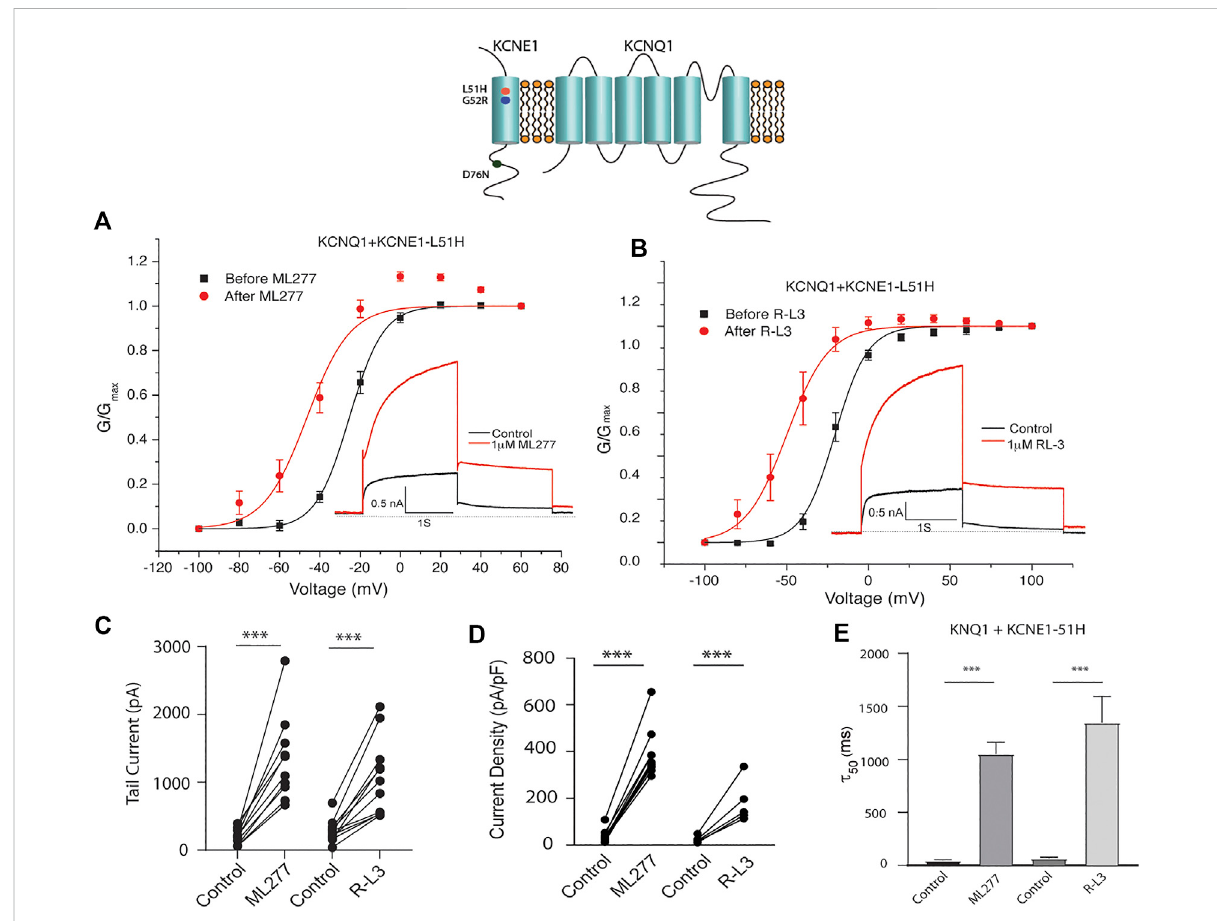
FIGURE 4 Potentiation of KCNQ1-L51H channel activity by ML277 and R-L3. (A) . Normalized conductance/voltage relationship for KCNQ1/KCNE1-L51H channels before (black traces) and after (red traces) application of 1 μ M ML277. The inset shows representative currents recorded at +60 mV. (B) . Normalized conductance/voltage relationship for KCNQ1/KCNE1-L51H channels before (black traces) and after (red traces) application of 1 μ M R-L3. The inset shows representative currents recorded at +60 mV. (C) . Tail current amplitudes measured at − 40 mV in control and 1 μ M ML277 and 1 μ M R-L3 solutions. (D) . Summary data for KCNQ1/KCNE1-L51H peak current density measured 2 s at +60 mV in the absence and presence of 1 μ M ML277 and 1 μ M R-L3. Data in each cell are connected by straight lines. (E) . Summary of measurement of slow deactivation time constant ( τ 50) in the absence and presence of both drugs. ML277: n = 10; R-L3: n =